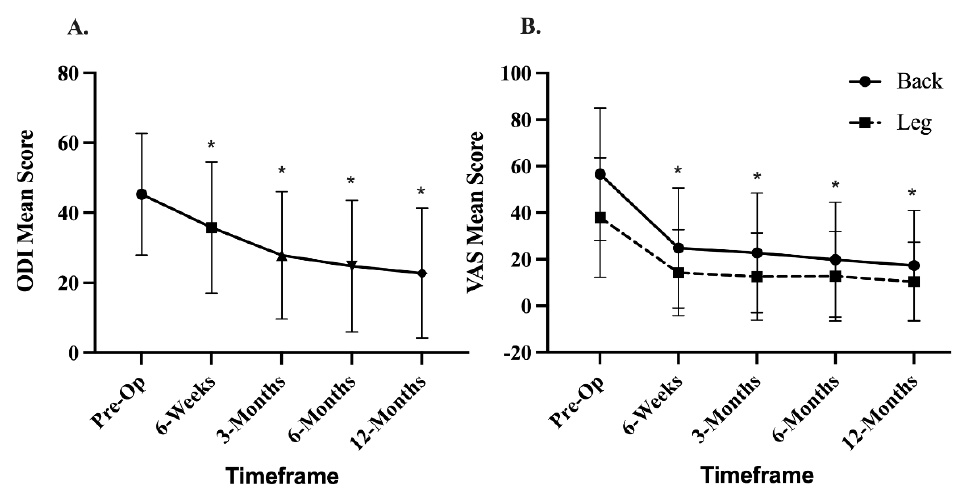
Figure 3. ODI and VAS scores through 12 months postoperation. ( A ). Mean ODI scores up to